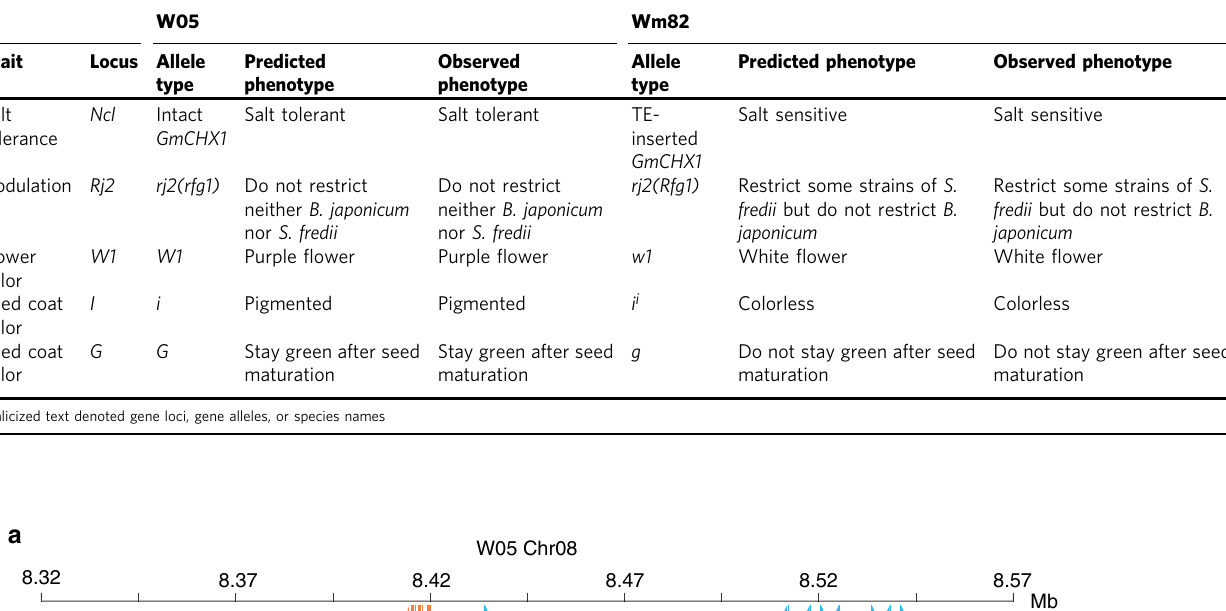
Table 2 Predicted phenotypes based on genomic assemblies and observed phenotypes *